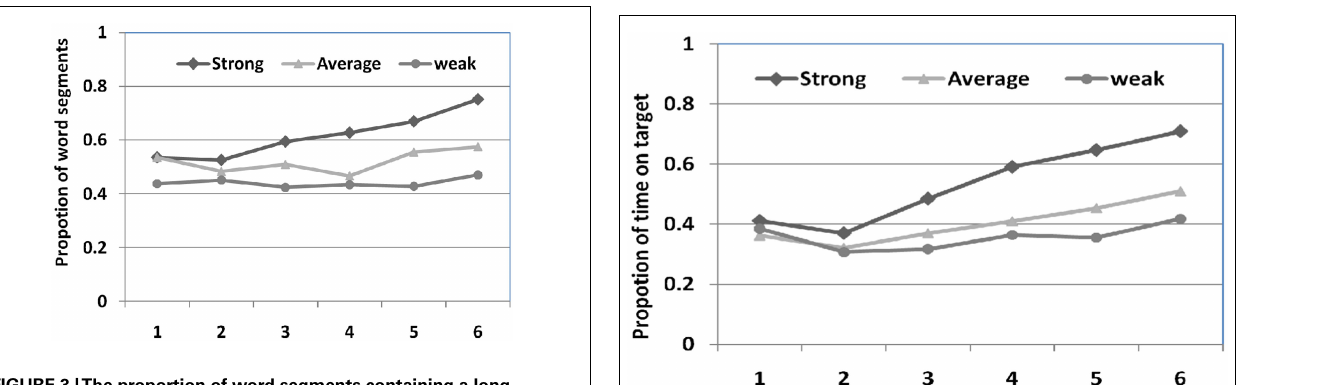
FIGURE 3 |The proportion of word segments containing a long accumulated look on an object ( > 1200ms) after hearing a word. Each word appeared six times in training. For all three groups, more than 40% of time they generated a long look throughout the training. In addition, strong learners gradually produced more and more long looks (75% at the end of training) while average and weak learners did not show the same trend.